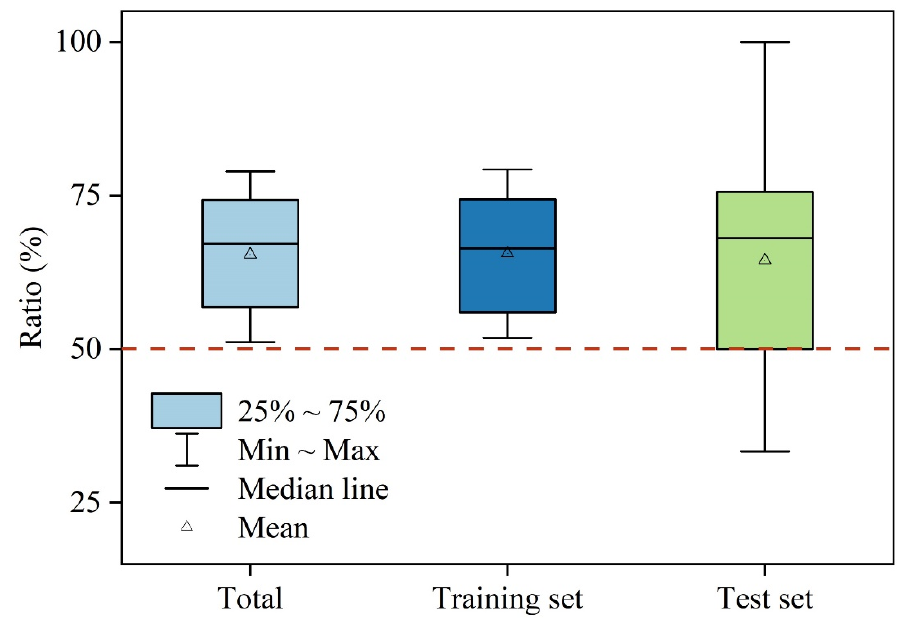
Figure 6. The distribution of the ratio of the waveform similarity coefficient increases after error correction among the total GEDI footprints, training set, and test set. The triangle is the mean value. If the ratio is less than 50%, the correction effect is poor.